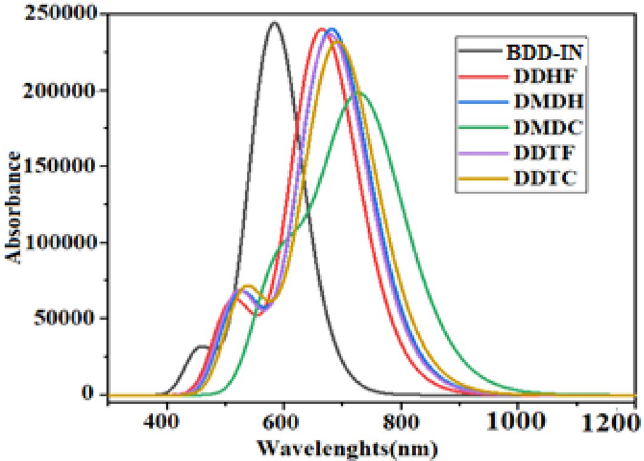
Figure 6. Graphical representation of UV–Visible absorption spectra of studied compounds.